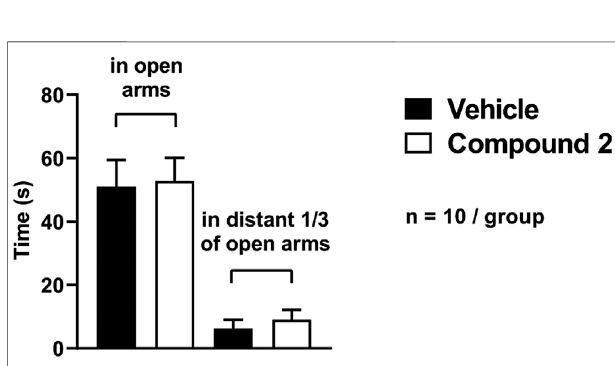
FIGURE 6 | Anxiety-like behavior quanti fi cation using EPM. Results are expressed as means ± S.E.M., data were analyzed by Student ’ s unpaired t- test, n (cid:2)